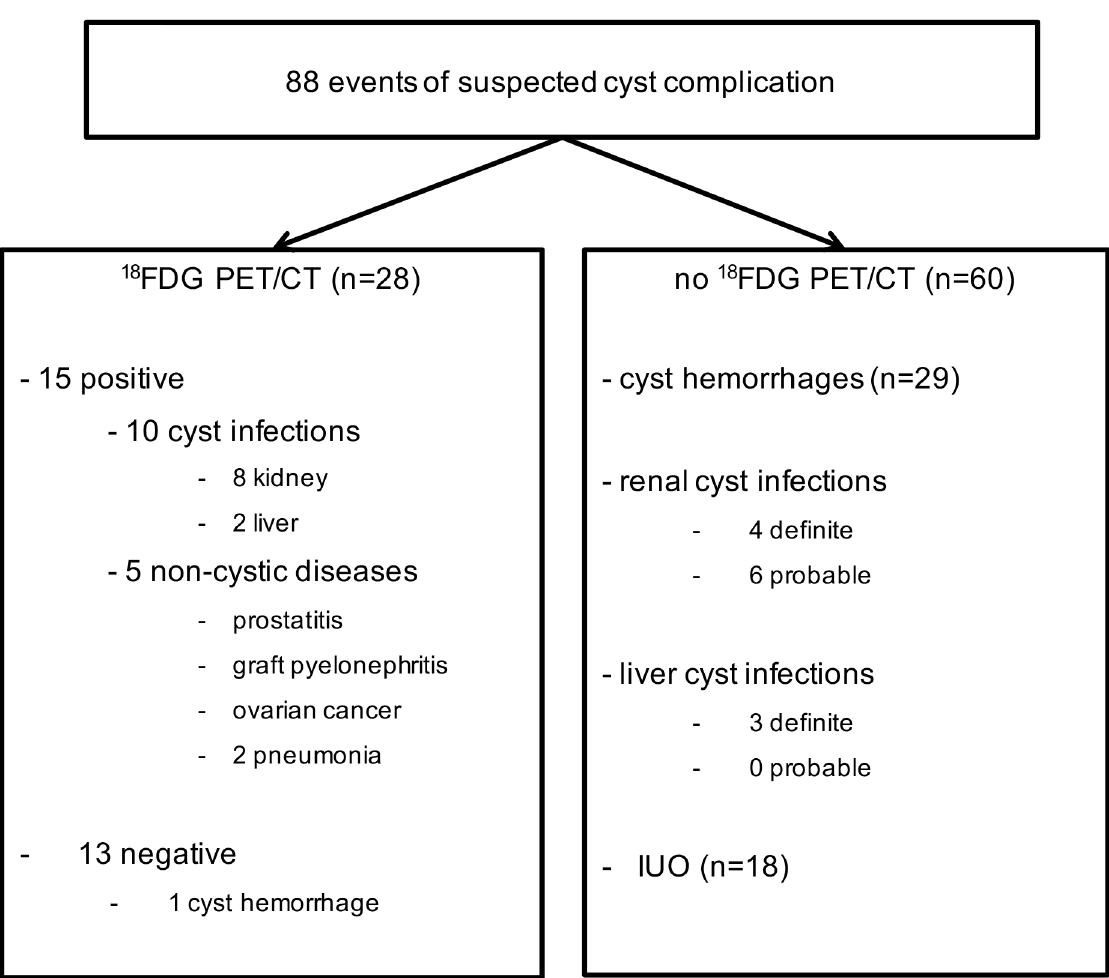
Fig 2. Distribution of 18 FDG-PET/CT imaging in patients with autosomal dominant polycystic kidney disease (ADPKD) presenting with suspected cyst complication. The final diagnosis is provided on the basis of the entire